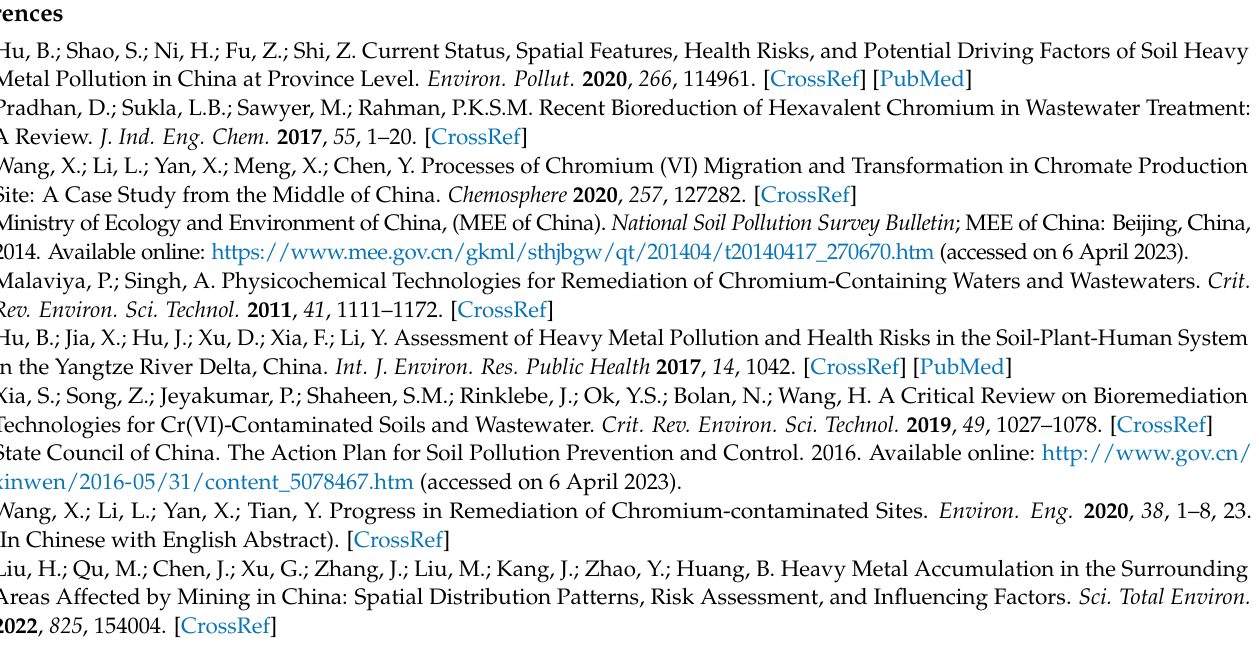
Table S4: Classification of the monomial potential ecological risk index ( E ); Table S5: Toxicological parameters of Cr; Table S6: Parameter distribution in Monte Carlo simulation; Table S7: Statistical information of the non-carcinogenic risk of all the collected regions and for different region types; Table S8: Industrial regions with soil Cr concentration exceeding the screening value (2500 mg/kg); Text S1: The criteria for paper screening; Text S2: The methodological details for health risk assess- ment; Figure S1: Distribution of major Cr-related industries in